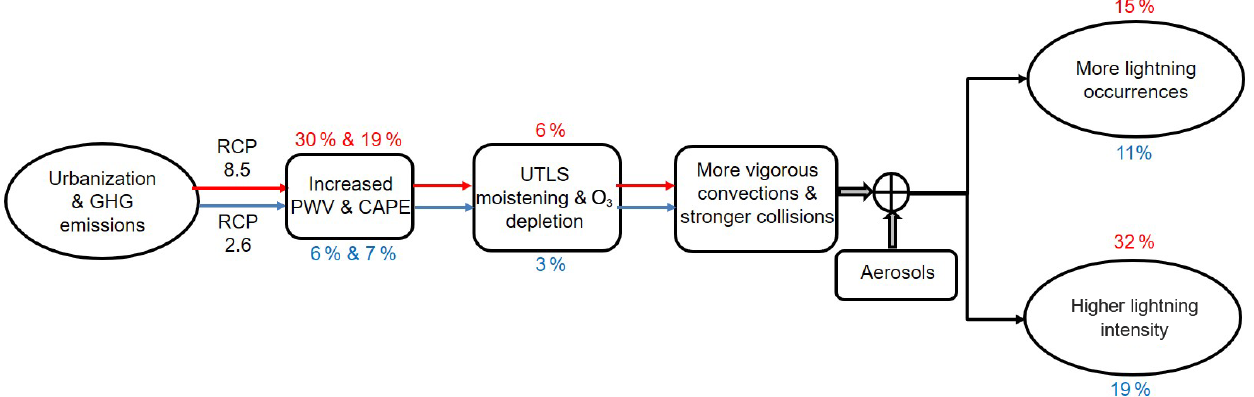
Figure 8. Proposed hypothesis to explain the long-term growth in lightning properties over the Indian region between the present (2016– 2020) and the distant future (2096–2100) assuming the RCP2.6 and RCP8.5 scenarios shown in blue and red,